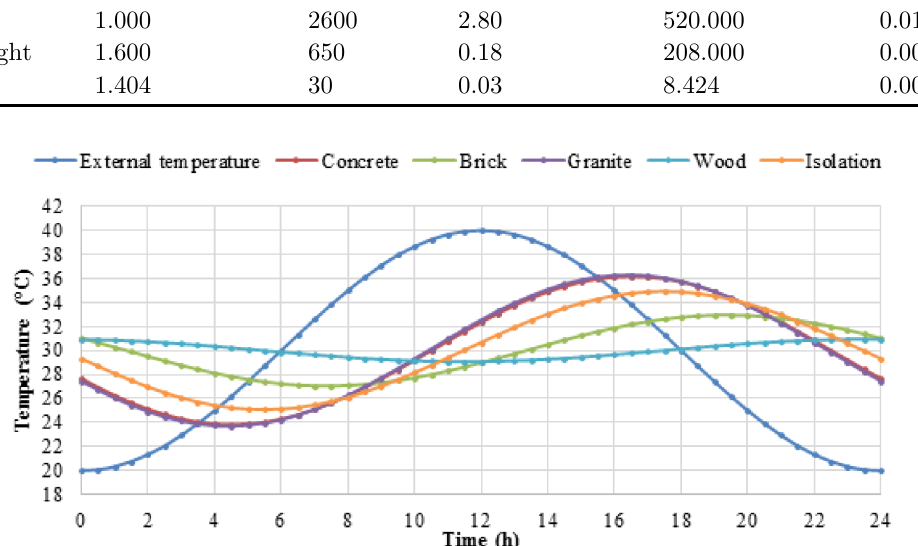
Fig. 3. Representation the response in the inner surface of different materials with a 20 cm thickness when the system is perturbed from a sine wave. Table 2. Summary of the results obtained in the simulation for different materials with a 20 cm thickness. Material